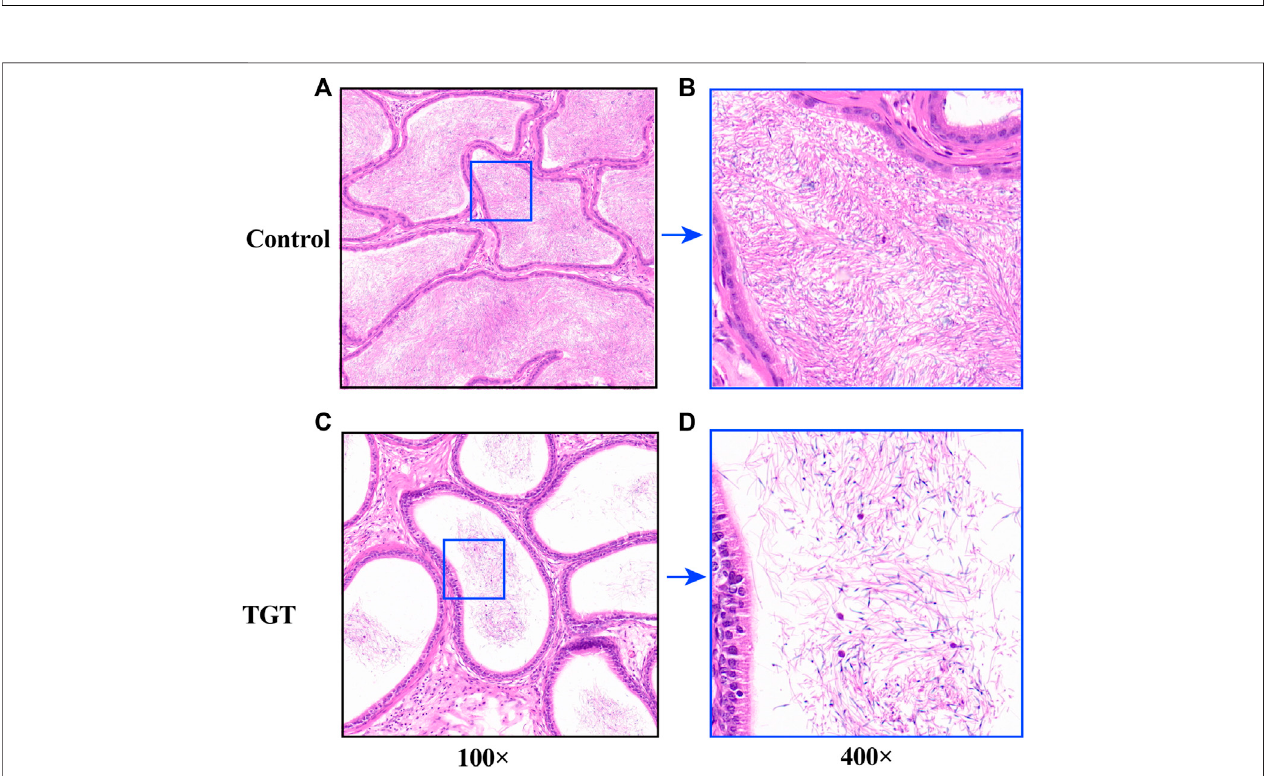
FIGURE 4 | (A) Testicular pathology in the control group (×100). (B) Testicular pathology in the control group (×400). (C) Testicular pathology in the TGT group (×100). (D) TesticularpathologyintheTGTgroup(×400). (E) Changesinthenumberofspermatogeniccellsinthetwogroups.Allvaluesrepresentthemeans±SD( n =3, compared with the control group: ppp p <